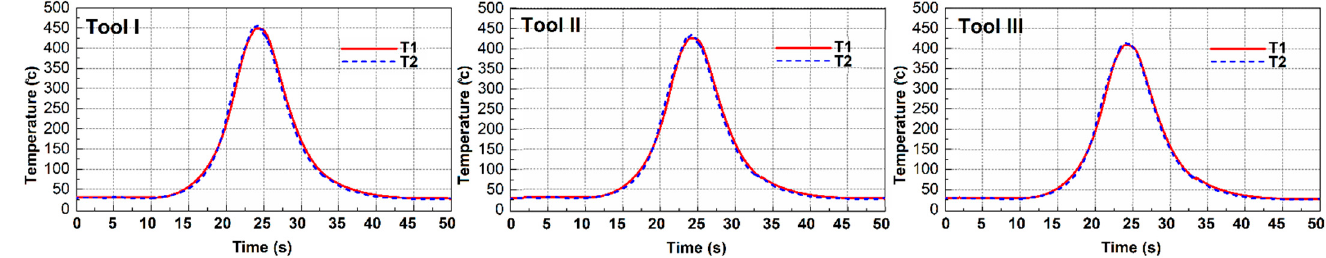
Figure 3. recorded temperature by thermocouple 1 and 2 at different tool